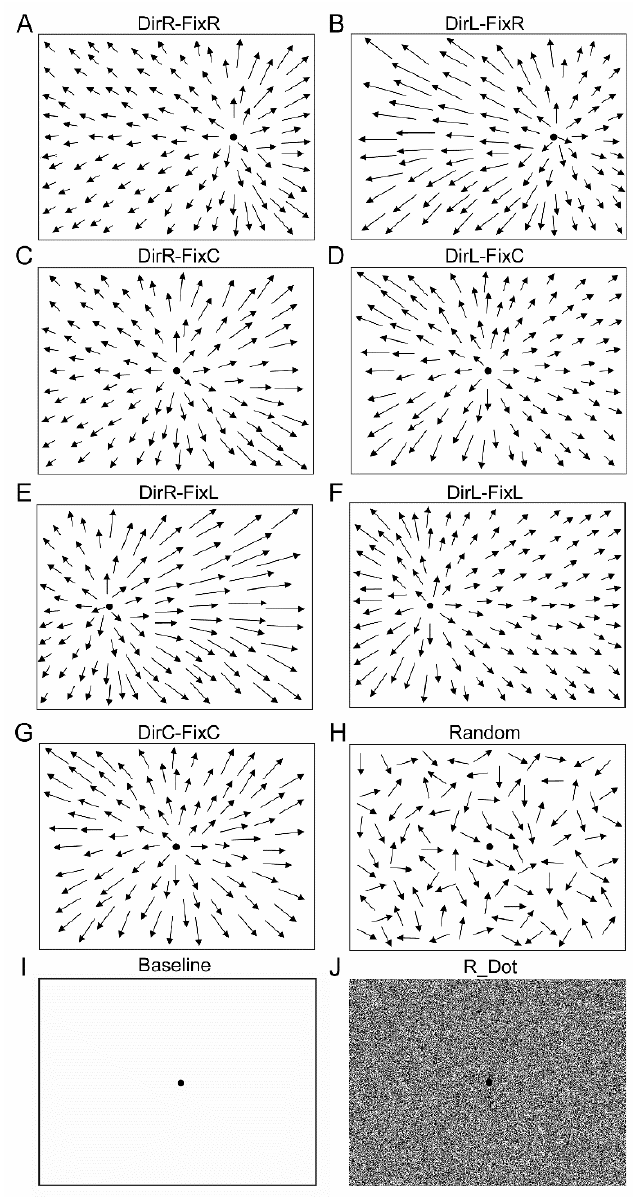
Figure 1. Optic flow and control stimuli. ( A ) Fixation point (FP) to the right and dots accelerated to the right simulated heading direction to the right while fixation was to the right (DirR-FixR). ( B ) FP to the right and dots accelerated to the left simulated heading direction to the left while fixation was to the right (DirL-FixR). ( C ) FP to the center and dots accel- erated to the right simulated heading direction to the right while fixation was straight ahead (DirR-FixC). ( D ) FP to the center and dots accelerated to the left simulated heading direction to the left while fixation was straight ahead (DirL-FixC). ( E ) FP to the left and dots accelerated to the right simulated heading direction to the right while fixation was to the left (DirR-FixL). ( F ) FP to the left and dots accelerated to the left simulated both heading and fixation to the left (DirL-FixL). ( G ) Radial expansion concentric with the FP simulated heading direction and fixation straight ahead (DirC-FixC). ( H ) Random dot motion (Random). ( I ) Baseline condition (Baseline). ( J ) Static random dots (R_Dot). Arrows represent the velocity vectors of moving